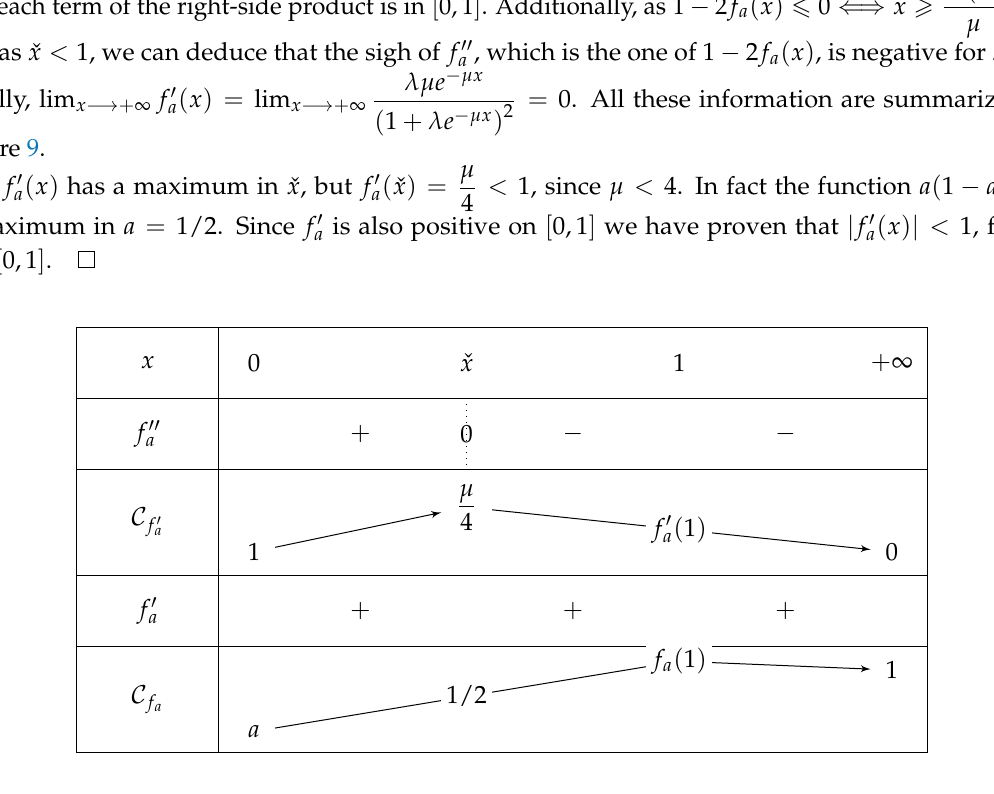
Figure 9. Behavior of f a